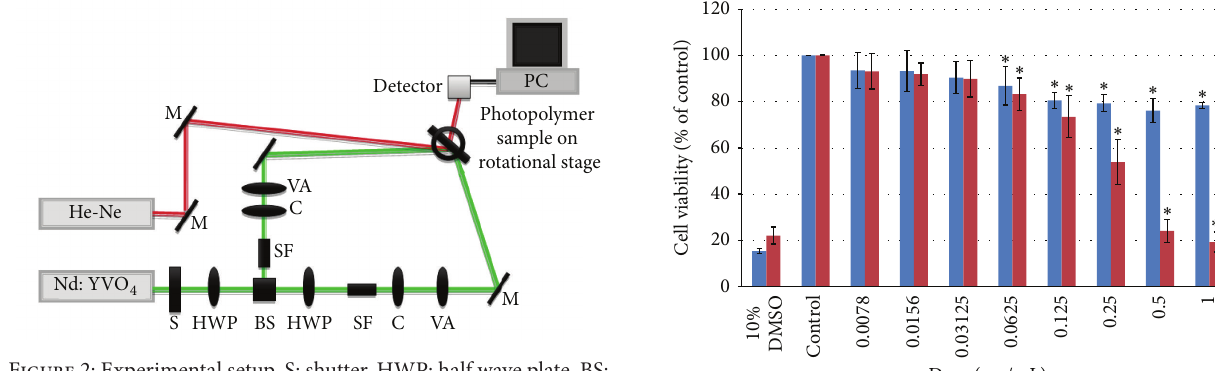
Figure 2: Experimental setup. S: shutter, HWP: half wave plate, BS: polarising beam splitter, SF: spatial filter, C: collimator, VA: variable aperture, M: mirror.